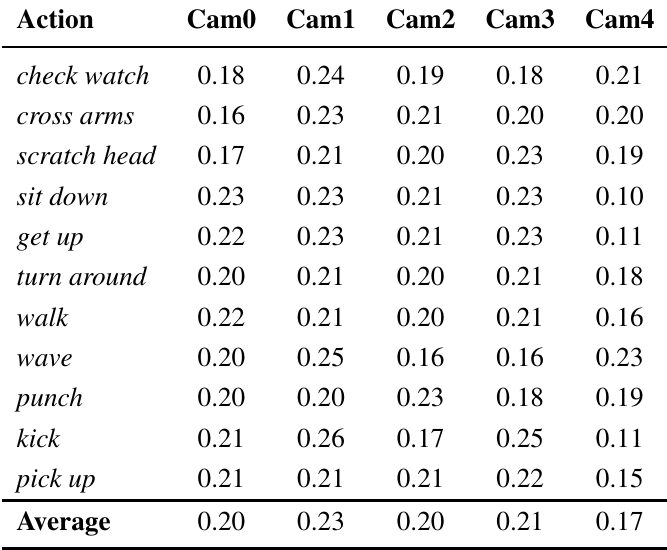
Table 7. Camera weights that have been obtained for the five views of the IXMAS dataset using the proposed weighted feature fusion